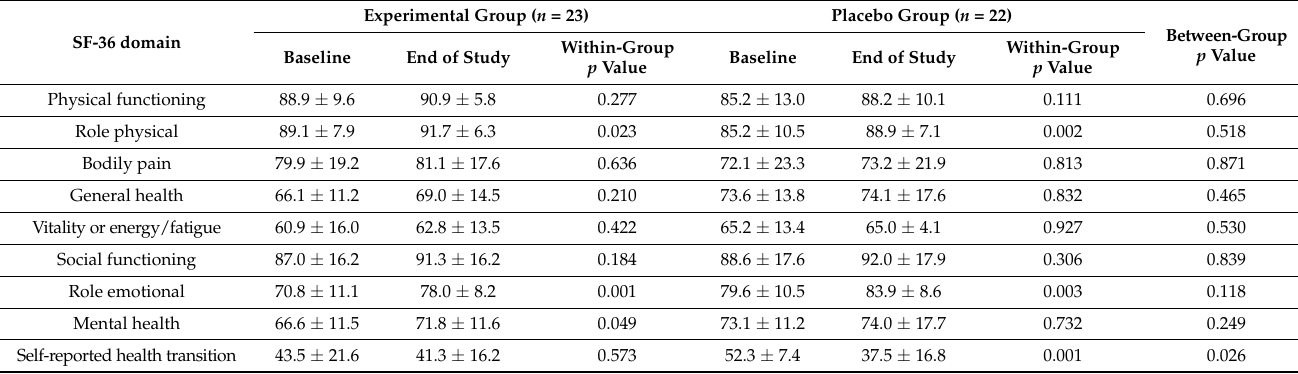
Table 6. Changes in HRQoL (SF-36 questionnaire) at the study after 12 weeks of food supplementation with a spinach extract or placebo.